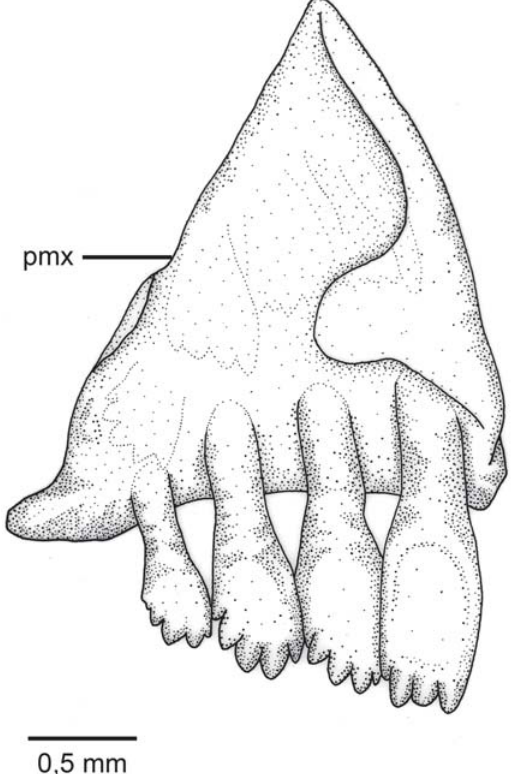
Fig. 3. Premaxillary (pmx) of Laemolyta fernandezi , INPA 12234, 93.7 mm SL, left side, medial